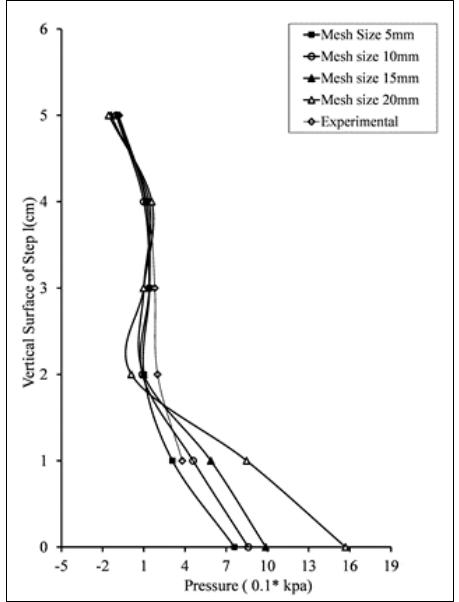
Figure 5. Grid Sensitivity Analysis.